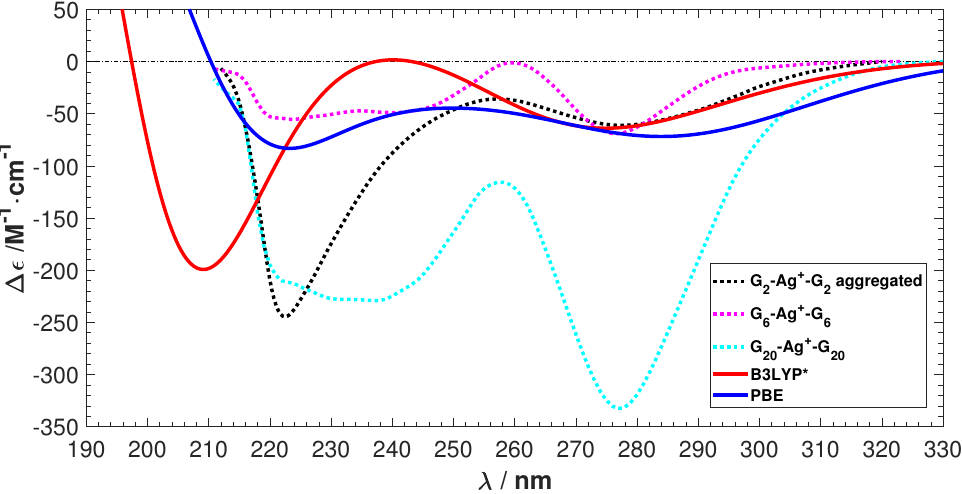
Figure 10. The experimental ECD [20] spectra shown along with our best prediction by B3LYP*. No shiftings of spectra are